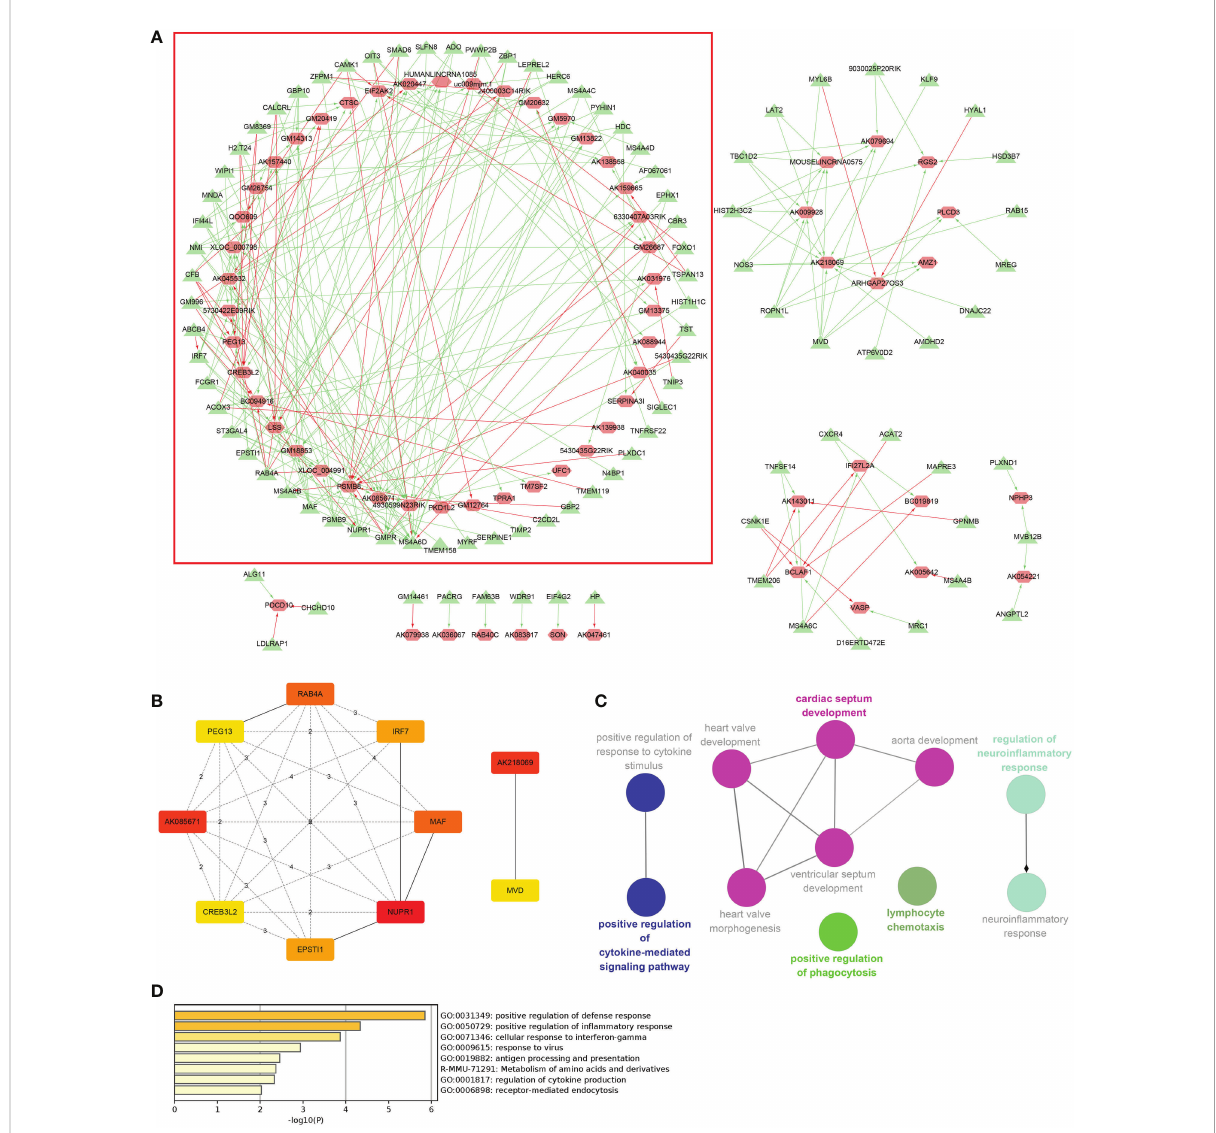
FIGURE 5 Coexpression analysis for DElncRNAs-DEmRNAs. (A) The coexpression network of DElncRNAs-DEmRNAs and the largest network with the most hub nodes in the red frame were selected (lncRNA: red; mRNA: green). (B) Hub nodes in all networks. (C) Gluego for 58 mRNAs in the largest network. (D) GO analysis for 58 mRNAs in the largest